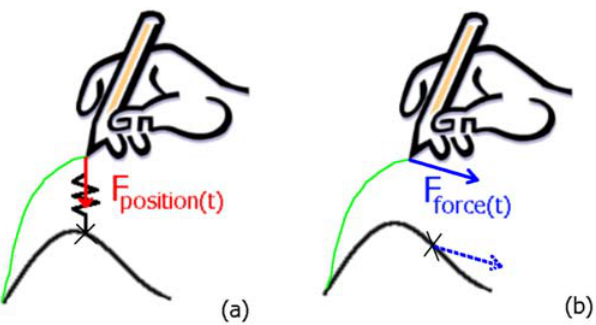
Figure 1. Schematic view of haptic guidances: (a) Haptic guidance in position (HGP); the force felt by the user at time t is proportional to displacement between the current user position and the theoretical position on the model trajectory; (b) Haptic guidance in force (HGF); the force felt by the user at time t is the same as the force existing for the theoretical trajectory at the same time.